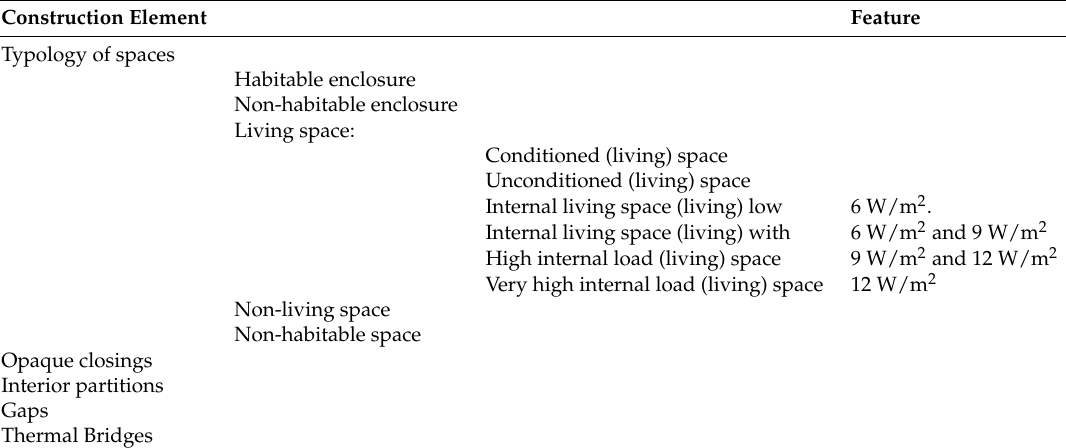
Table 4. Constructive elements that define the thermal model.